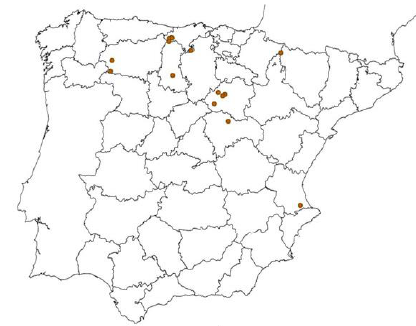
Figure 6. Geographical distribution of analysed half-timbered walls with light